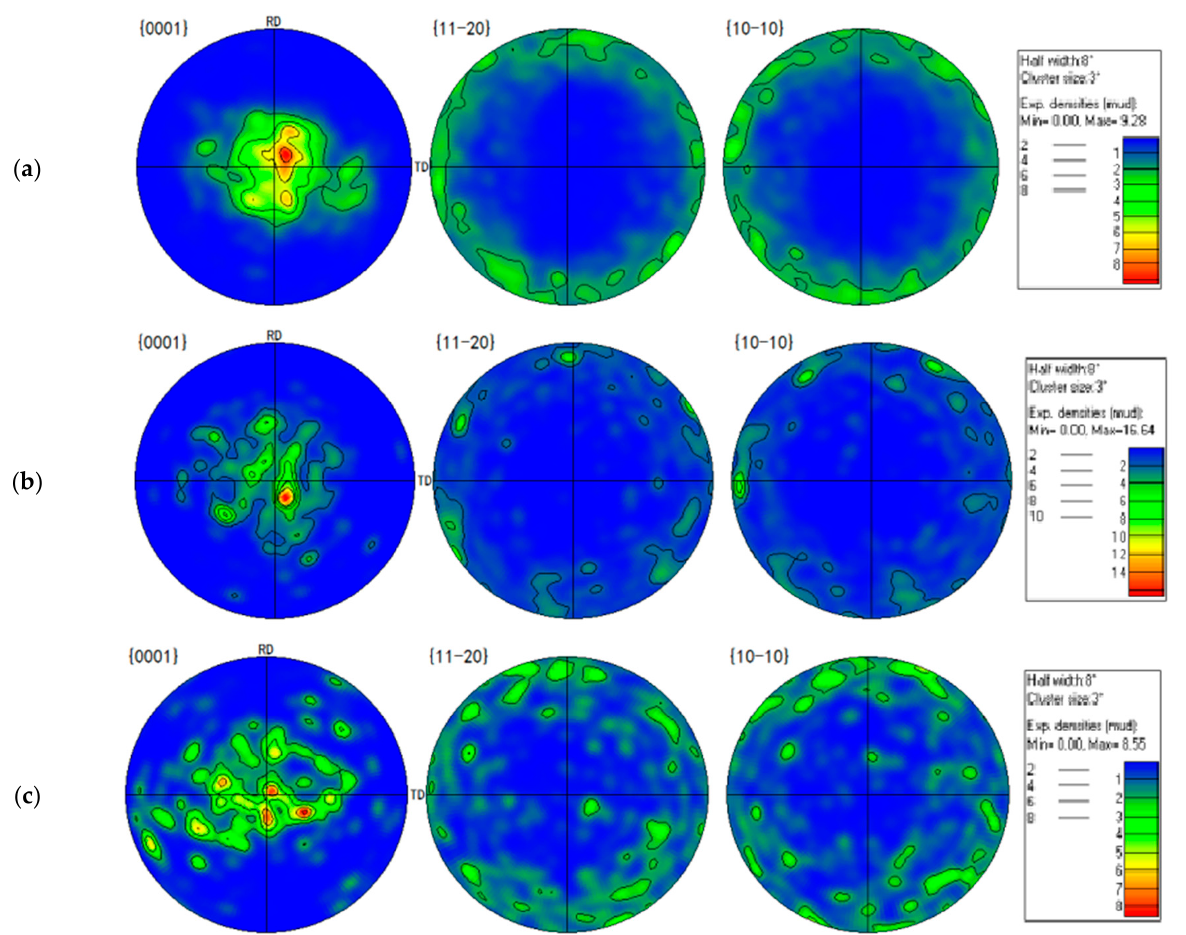
Figure 7. The PF maps of wrought AZ31-TD alloy at 1000 s − 1 under different temperatures: ( a ) 20 ◦ C, ( b ) 150 ◦ C, ( c ) 250 ◦ C.